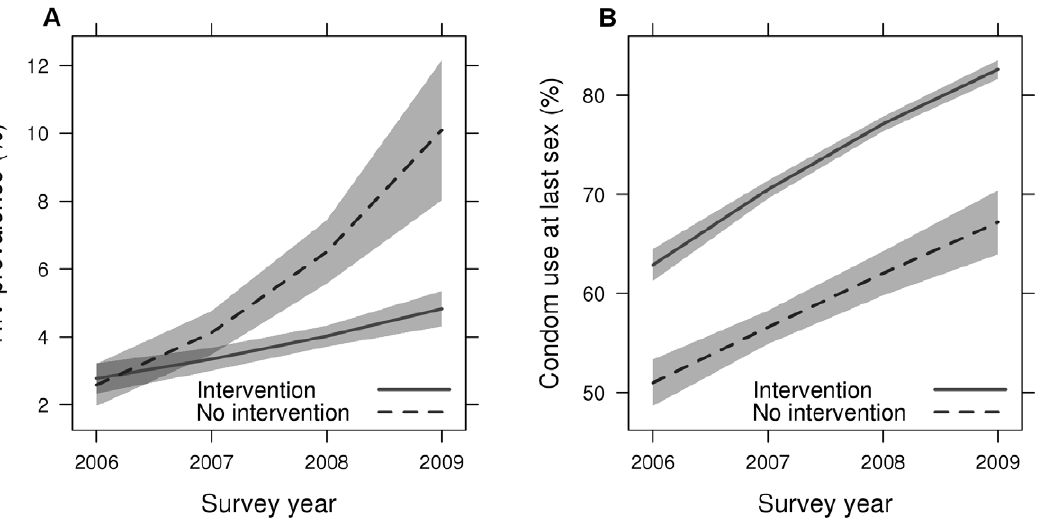
Figure 2. Marginal effects of intervention on condom use at last sex and HIV prevalence among Chinese MSM during 2006–2009 (shadows represent 95% confidence bands): Figure 2A: impact on HIV prevalence; Figure 2B: impact on condom use.